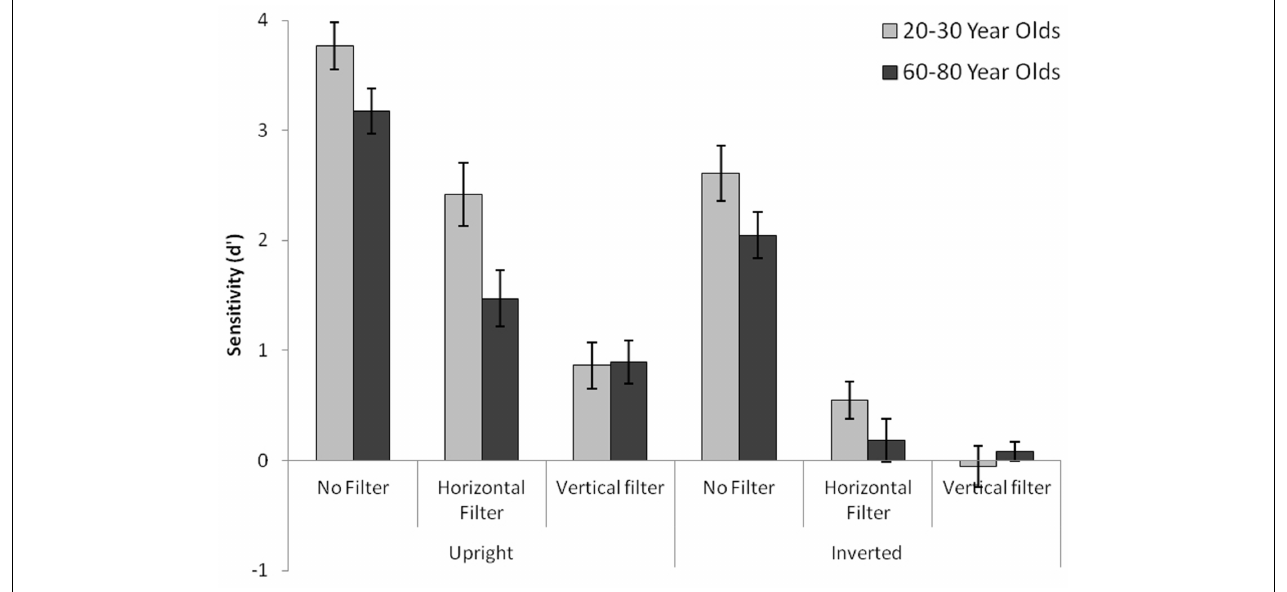
FIGURE 2 | Sensitivity scores for both age groups across different filter and orientation